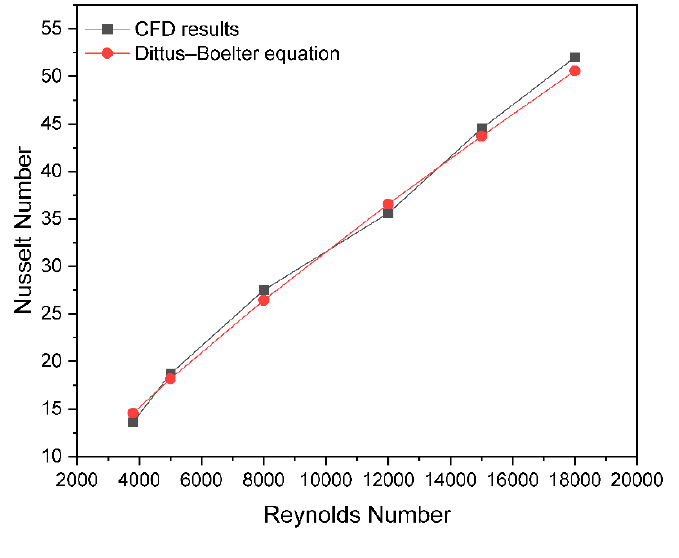
Figure 19. Validation of Nu .